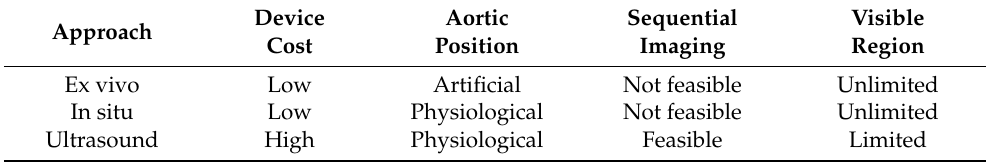
Table 2. Comparison of ex vivo, in situ, and ultrasound approaches for aortic imaging in